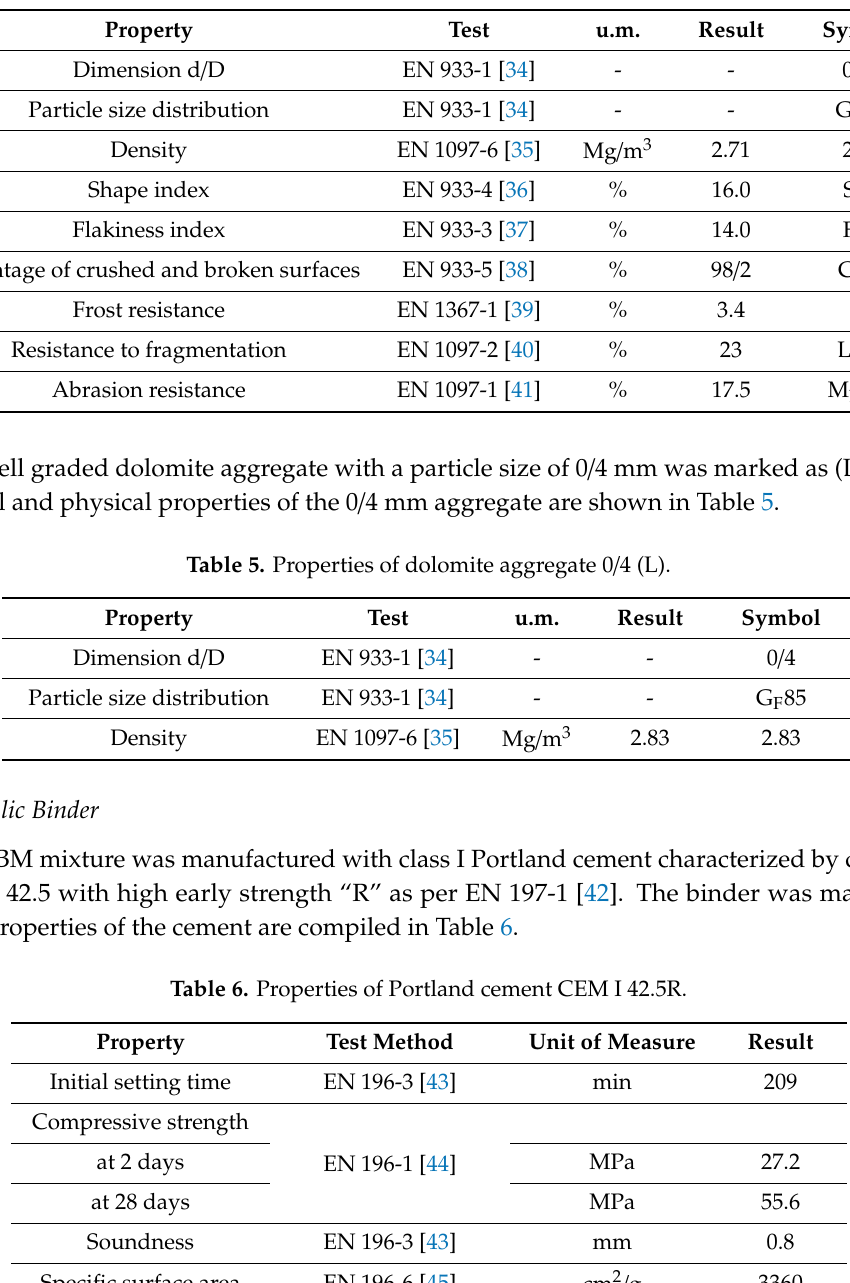
Table 4. Properties of dolomite aggregates 0 / 31.5 (J).